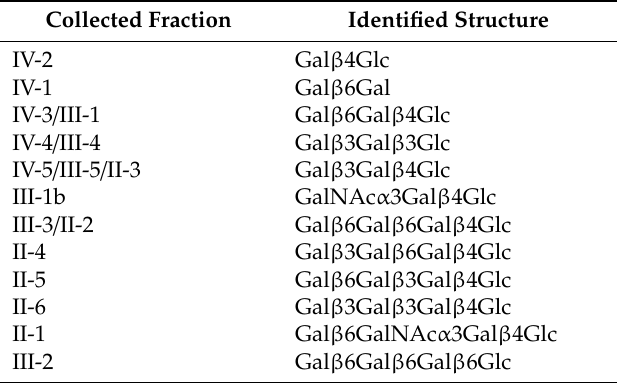
Table 1. Identified oligosaccharide